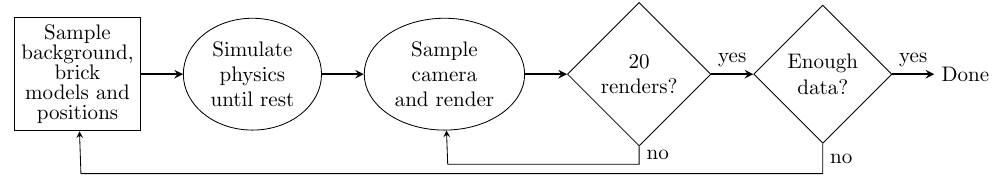
Figure 3. Synthetic data generation flowchart.